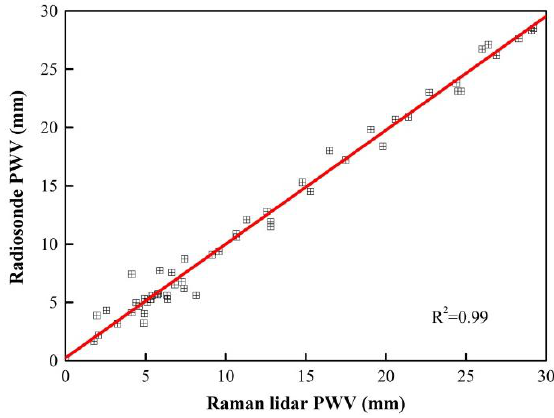
Figure 3. Scatter plot of correlation between Lidar PWV and radiosonde PWV.